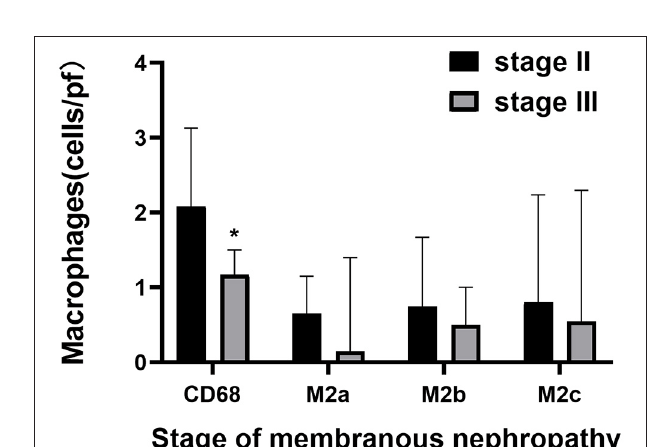
FIGURE 2 | The comparison of M2 macrophage subpopulations count in glomeruli between stage II and stage III of membranous nephropathy. Quantitative analysis of CD68, M2a, M2b, and M2c in membranous nephropathy stage II and stage III, Significant correlation * p <